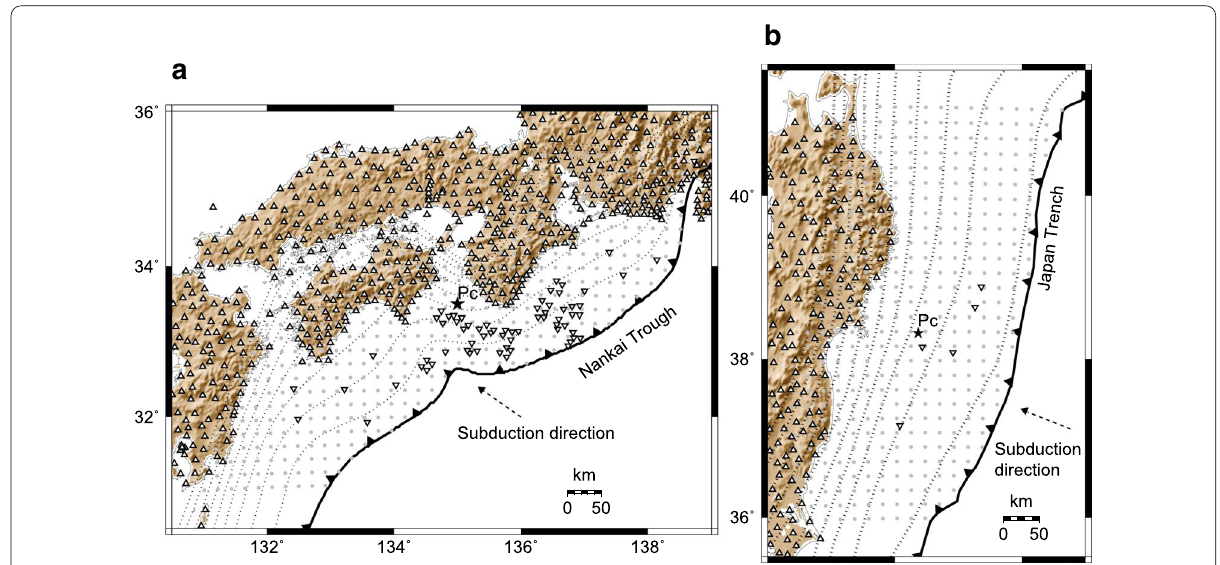
Fig. 3 Overview of the target regions for calculating GFs. a the Nankai Trough and b the Japan Trench subduction zones. Gray dots denote the central point of B-spline-function-shaped slip distribution applied in a subfault. Triangles and inverse triangles denote the GEONET and the representative seafloor stations (Kaneda et al. 2015; Sato et al. 2011; Yokota et al. 2016) of geodetic observation, respectively